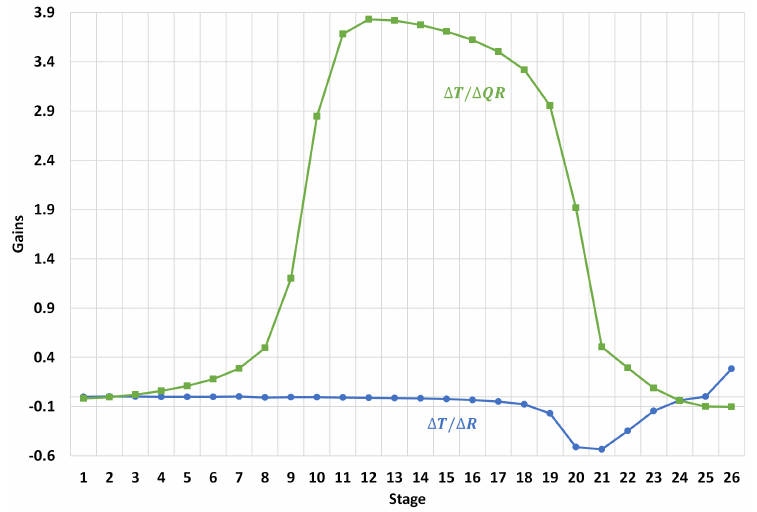
Figure 7. Sensor location for temperature control. Sensitivity analysis